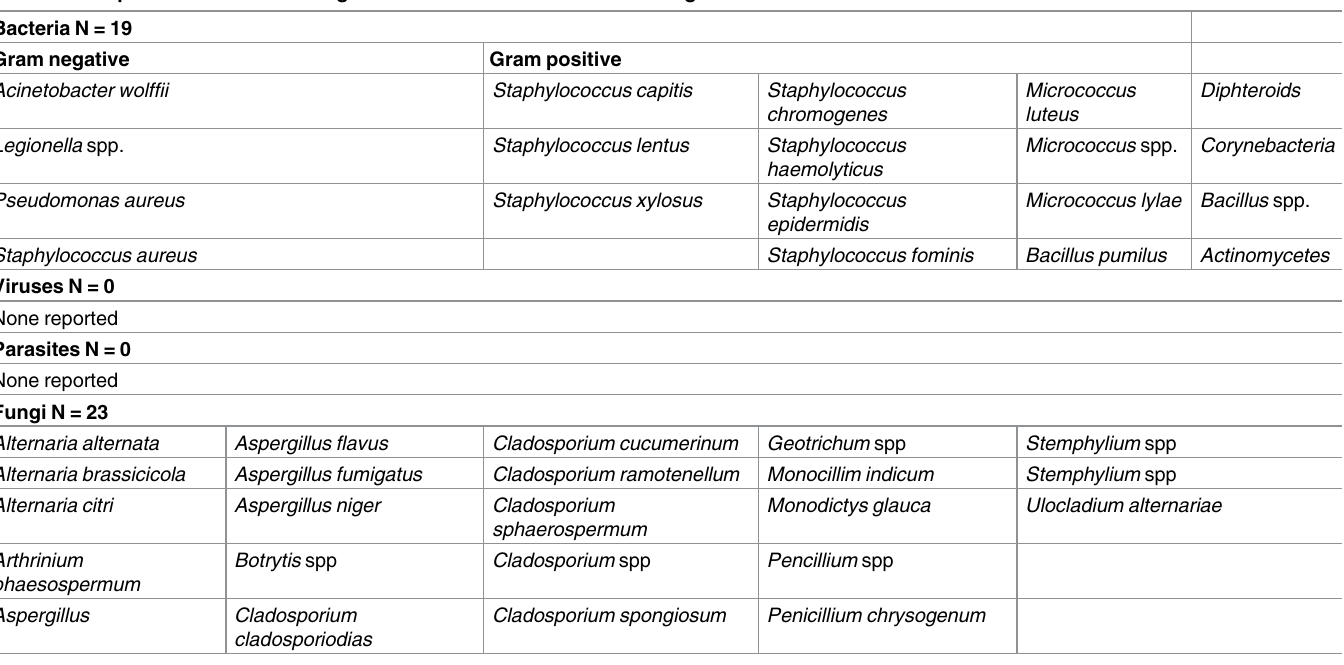
Table 3. Complete overview micro-organisms identified in the dental